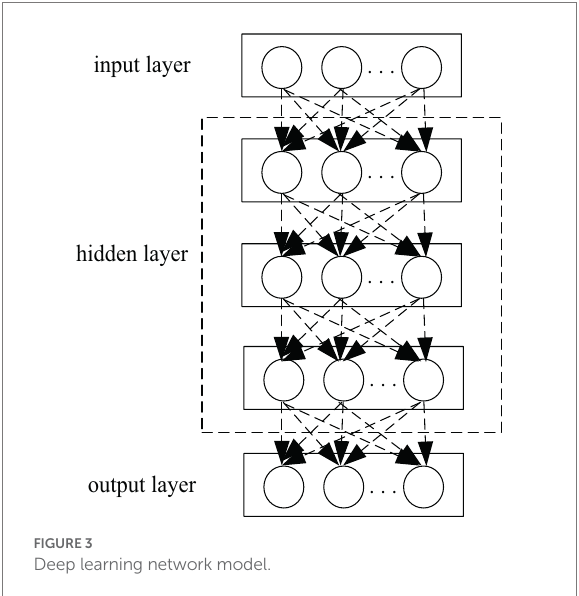
FIGURE 3 Deep learning network model.